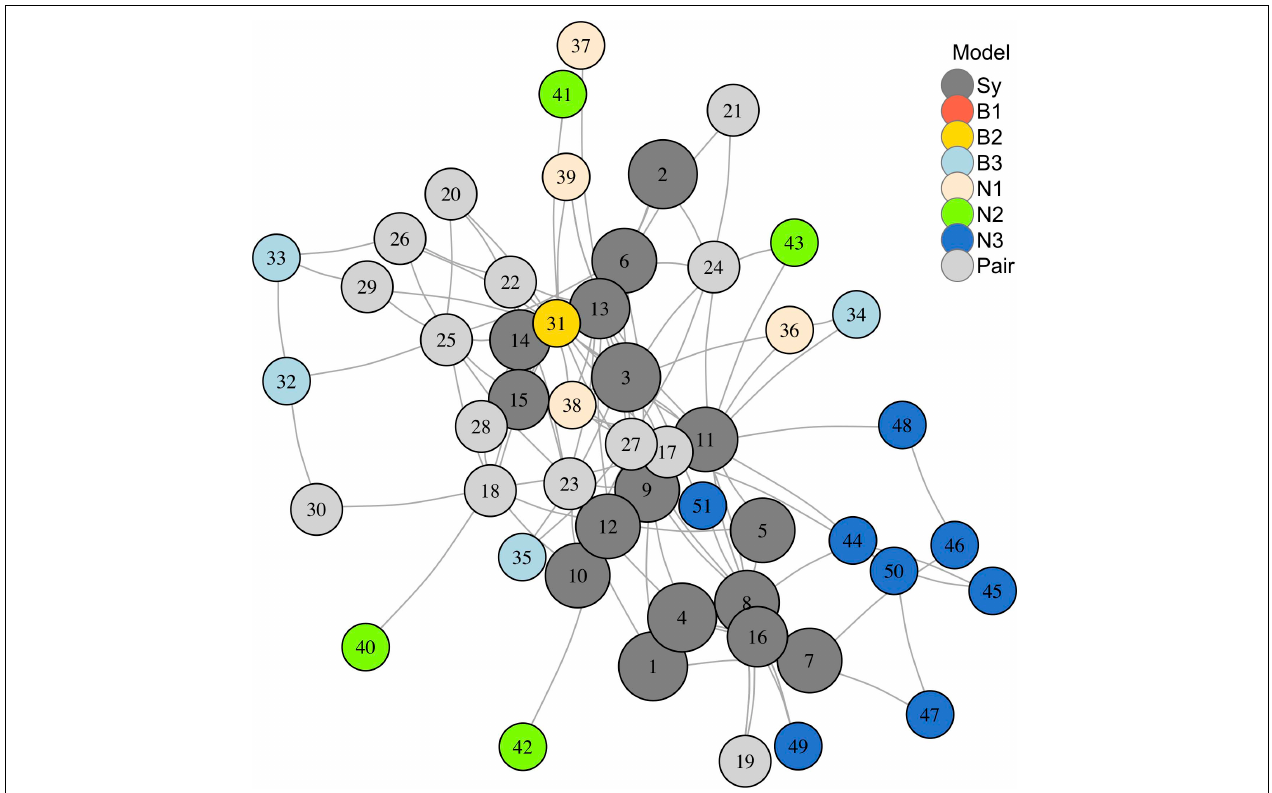
FIGURE 3 | Graphical summary of the six alternative representations elicited during the six stakeholder-specific workshops (B for Brittany and N for Normandy). Node size reflects the frequency of variable inclusion across the six models. Variables in dark gray are common to at least three of the six models, which was the criterion for inclusion in the synthesis (Sy) model. Light gray variables are common to two models. Variables in orange, yellow, light blue, beige, green and dark blue correspond to unique variables occurring, respectively, in B1, B2, B3, N1, N2, and N3 models. The 51 variables are numbered as follows, 1: Plankton, 2: